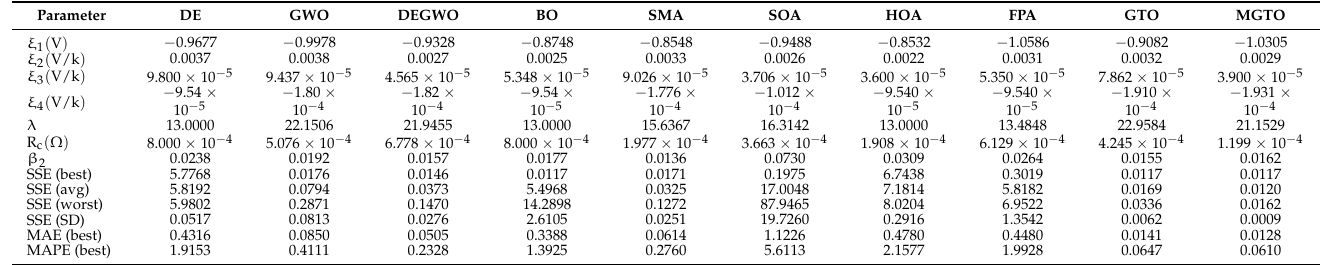
Table 3. Comparison among algorithms using test case 1.